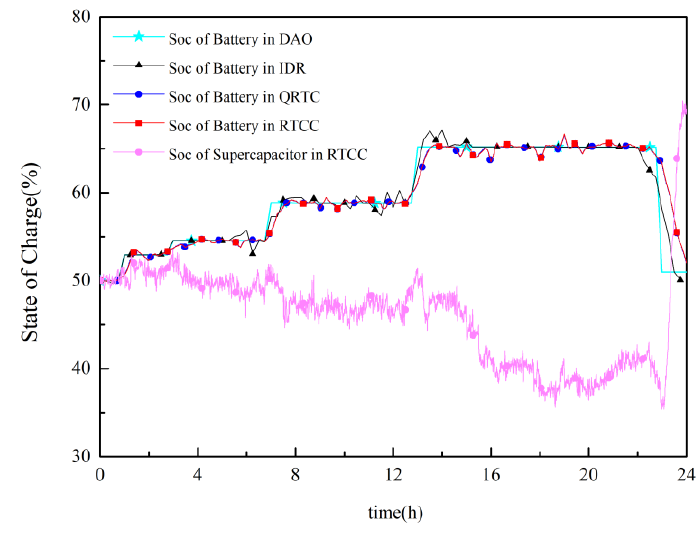
Figure 7. SOC curve of ETESS in various timescales.